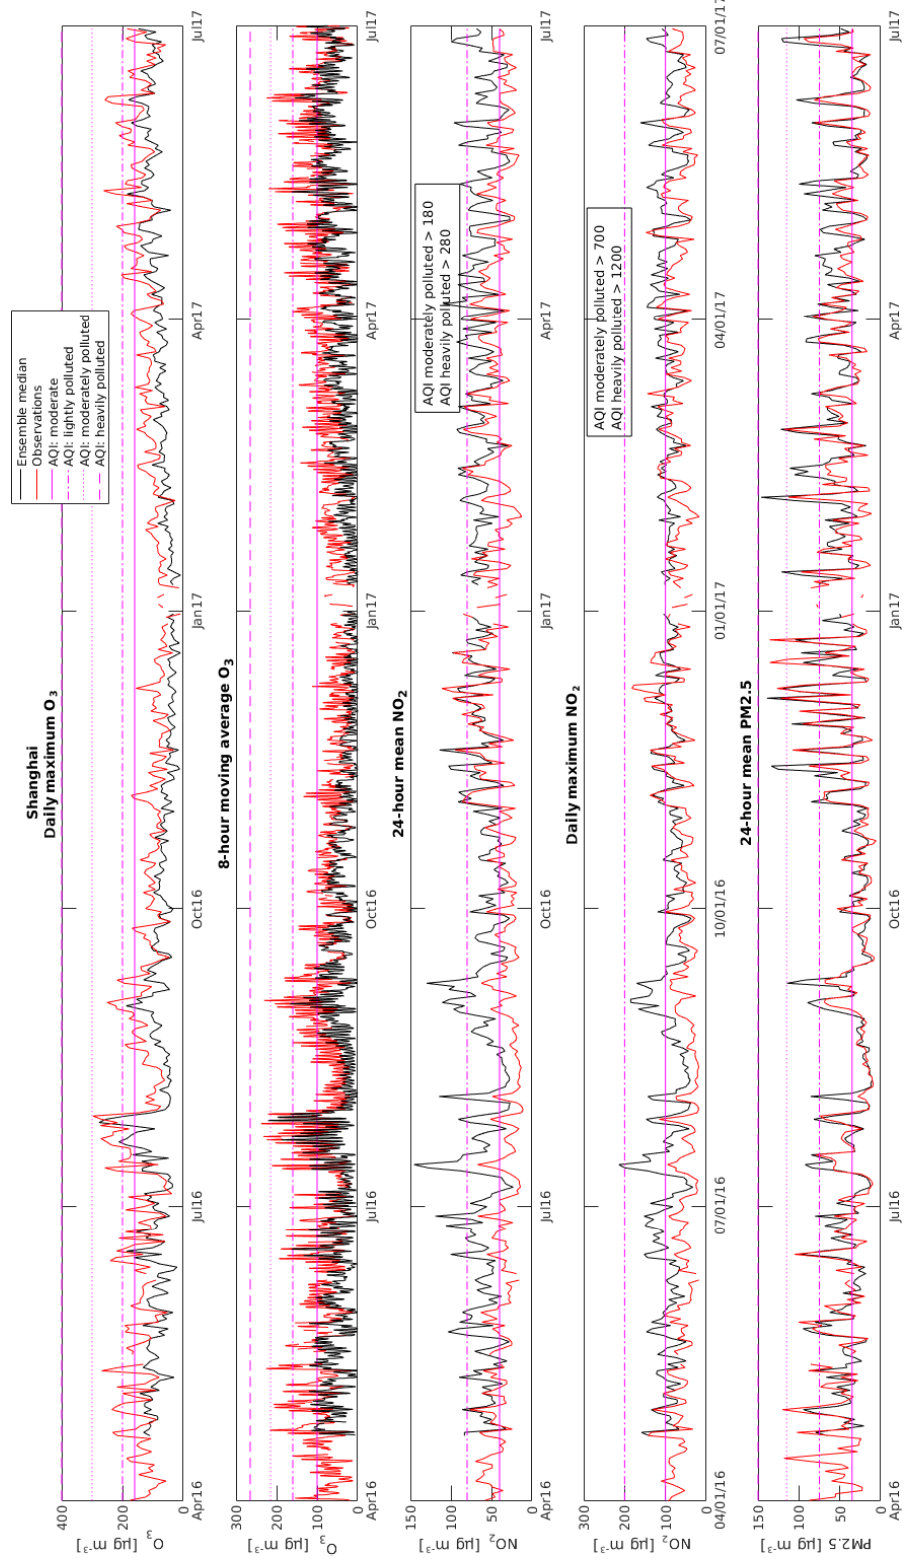
Figure 11. Time series of daily maximum O 3 , 8h moving average O 3 , 24h mean NO 2 , daily maximum NO 2 , and 24h mean PM 2 . 5 for Shanghai from April 2016 until June